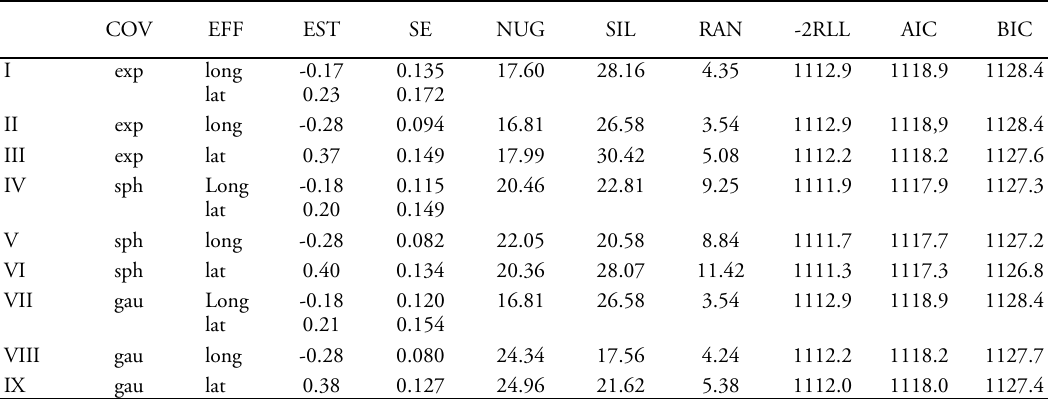
Nine different spatial models: covariance structure (COV), REML estimates (EST) of fixed effects (EFF) and their standard errors (SE) and estimated values of parameters (NUG, SIL, RAN), overall fit statistics (-2RLL, AIC,